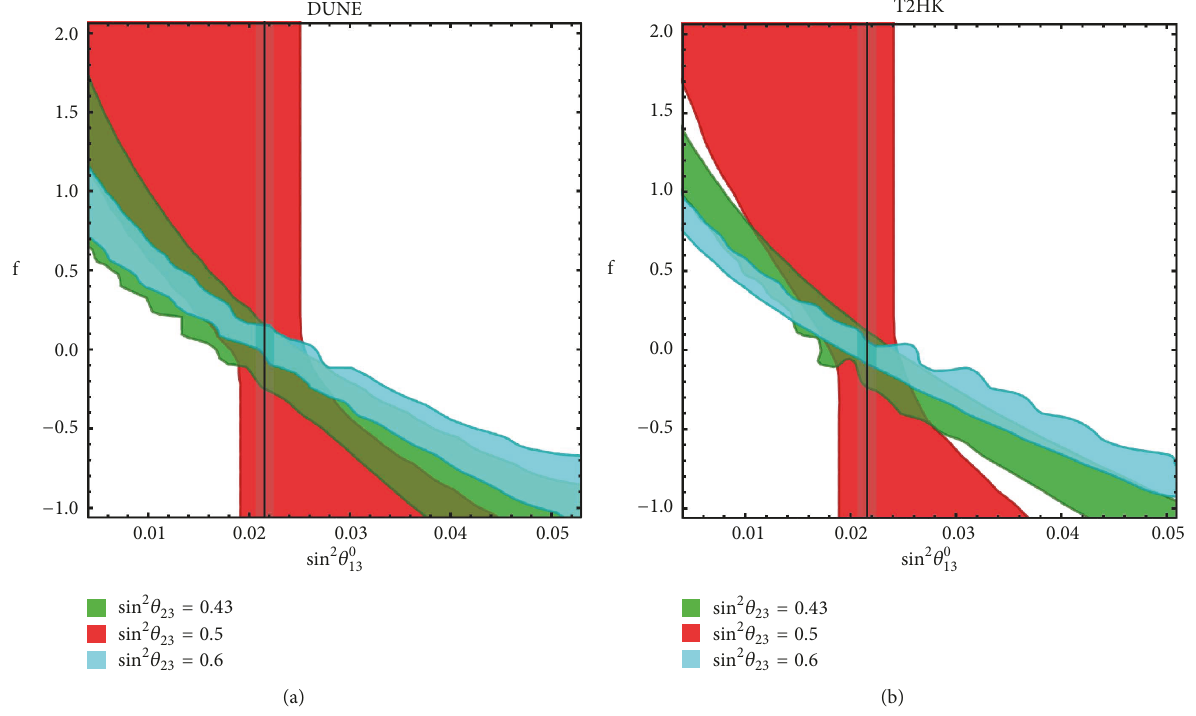
Figure 6: General parameter space regions that cannot be distinguished from the unconstrained relation hypothesis at more than 3𝜎 by future long-baseline neutrino oscillation experiments in combination with reactor measurements as a function of the two parameters of (15): 𝜃 0 𝑓 . The analysis assumed the central value of the reactor angle as the best fit given in Table 3 and three values for the atmospheric 13 and angle: (1) sin 2 𝜃 23 ( true ) = 0.43 (green), (2) sin 2 𝜃 23 ( true ) = 0.5 (red), and (3) sin 2 𝜃 23 ( true ) = 0.6 (cyan) for DUNE (a) and T2HK